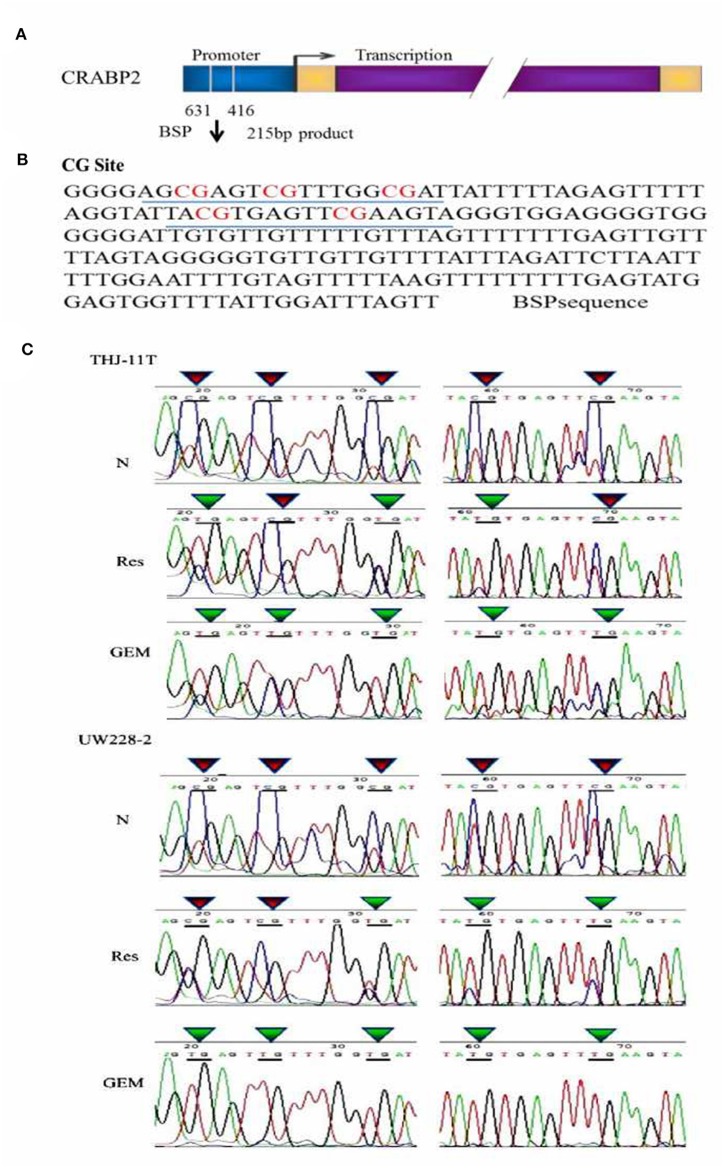
BSP sequencing demonstration of 5 CG site methylation of −631 to −416 CRABP2 promoter region and differential demethylation effects of resveratrol and gemcitabine (A) Scheme of CRABP2 gene and the location of BSP amplified promoter region; (B) the nucleotide sequence of BSP product and the locations of 5 CG sites; (C) demonstration of the sequencing result of the underlined region (B) of CRABP2 BSP product generated from UW228-2 and THJ-11T sample DNAs without (N) and with 48 h 100 μM resveratrol (Res) or 10 μM gemcitabine (GEM) treatment. In bisulfite sequencing PCR (BSP), the unmethylated C-bases become U-base in sulfite-treated DNA and are replaced by T-base after PCR; the methylated C-base cannot be converted by sulfite and remain as a C-base in the BSP product. Our sequencing results revealed five CpG methylation sites in the CRABP2 promoter region which were partially (3/5) erased (CpG to TpG) by resveratrol and completely (5/5) erased by gemcitabine.